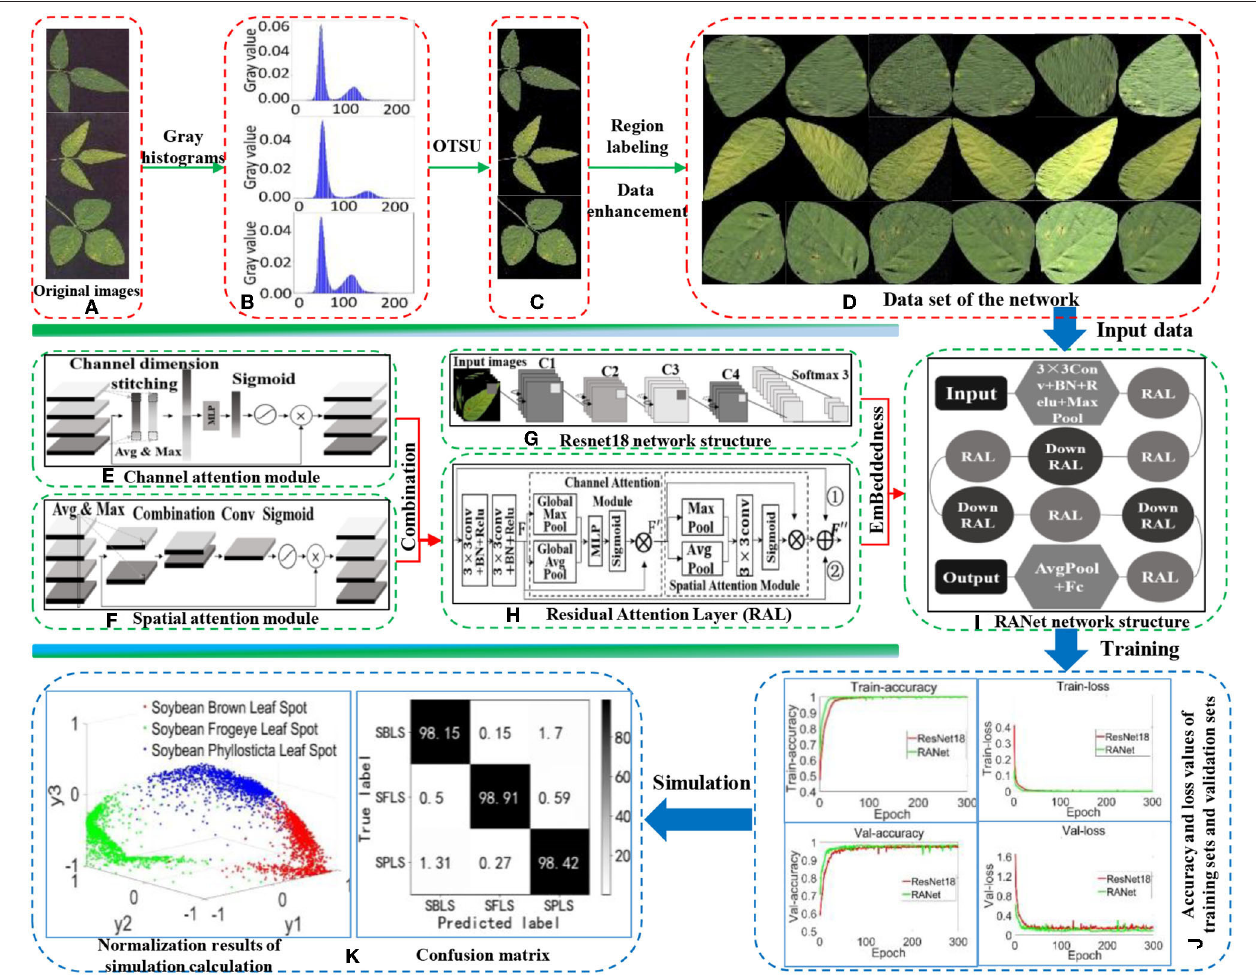
FIGURE 1 | Overall process of establishing the recognition model. (A) Original images. (B) Gray histogram. (C) The extracted images by OTSU. (D) Data set of the network. (E) Channel attention module. (F) Spatial attention module. (G) Resnet18 network structure. (H) Residual Attention Layer (RAL). (I) RANet network structure. (J) Accuracy and loss values of training sets and validation sets. (K) Normalization results of simulation calculation, confusion matrix.